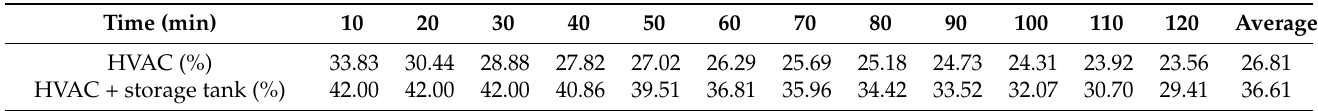
Figure 8. Electricity flexibility of office building over 2 h. Table 6. Energy flexibility ratio of total building energy demand of heating, ventilation, and air conditioning (HVAC) systems with and without storage tank.